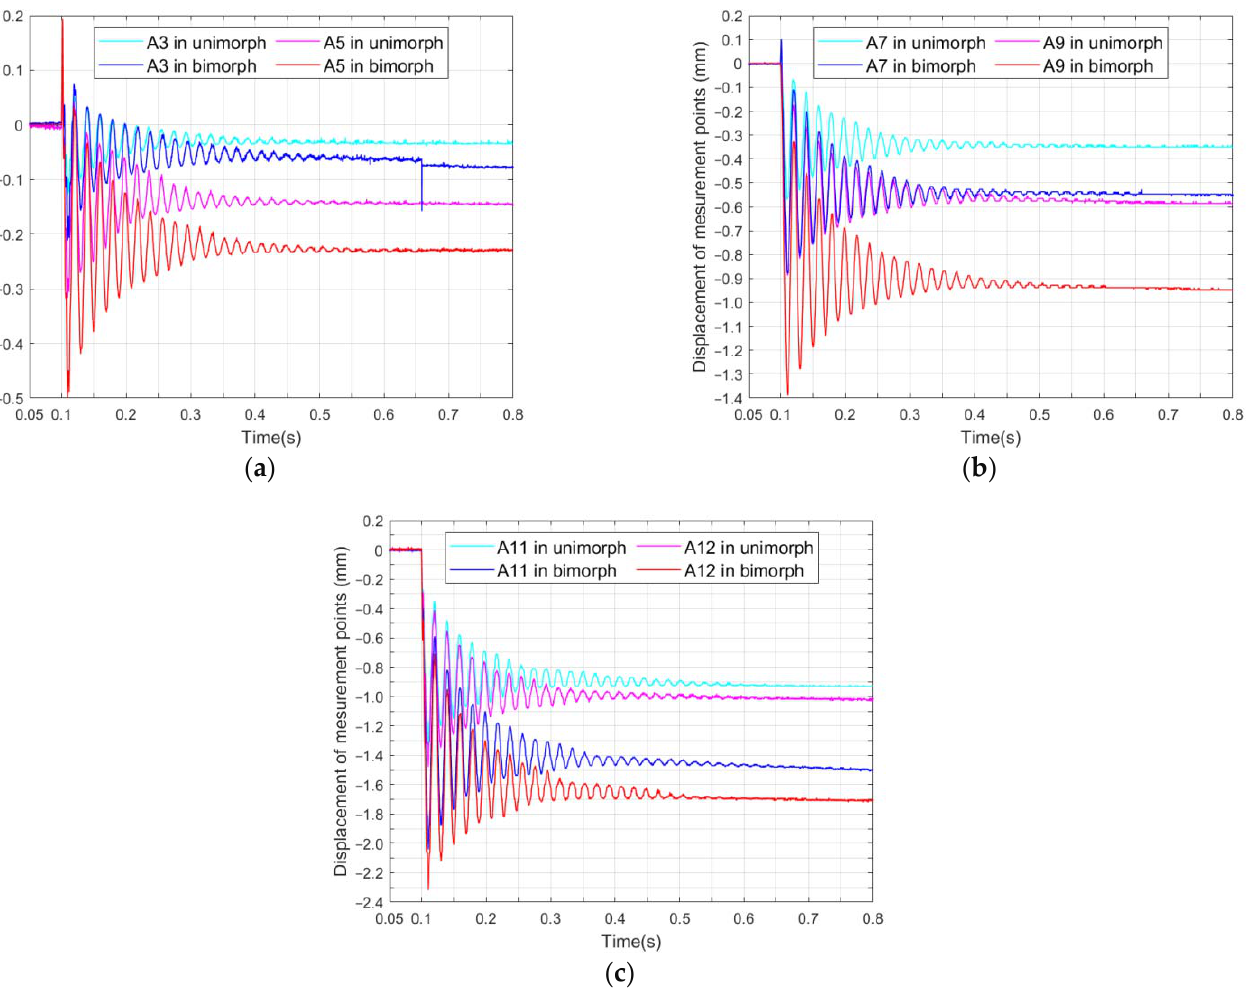
Figure 8. Transient part and the beginning of the creep phenomenon in an actuator step response: